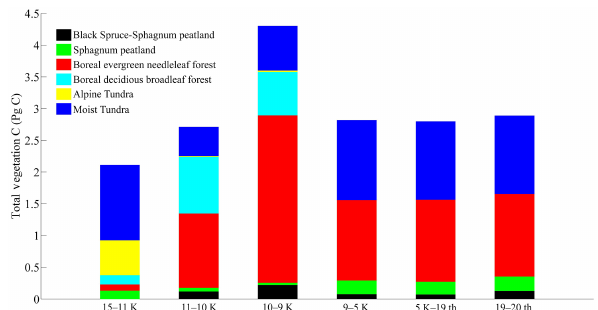
Figure 6. Total C (Pg C) stored in Alaskan vegetation for different time